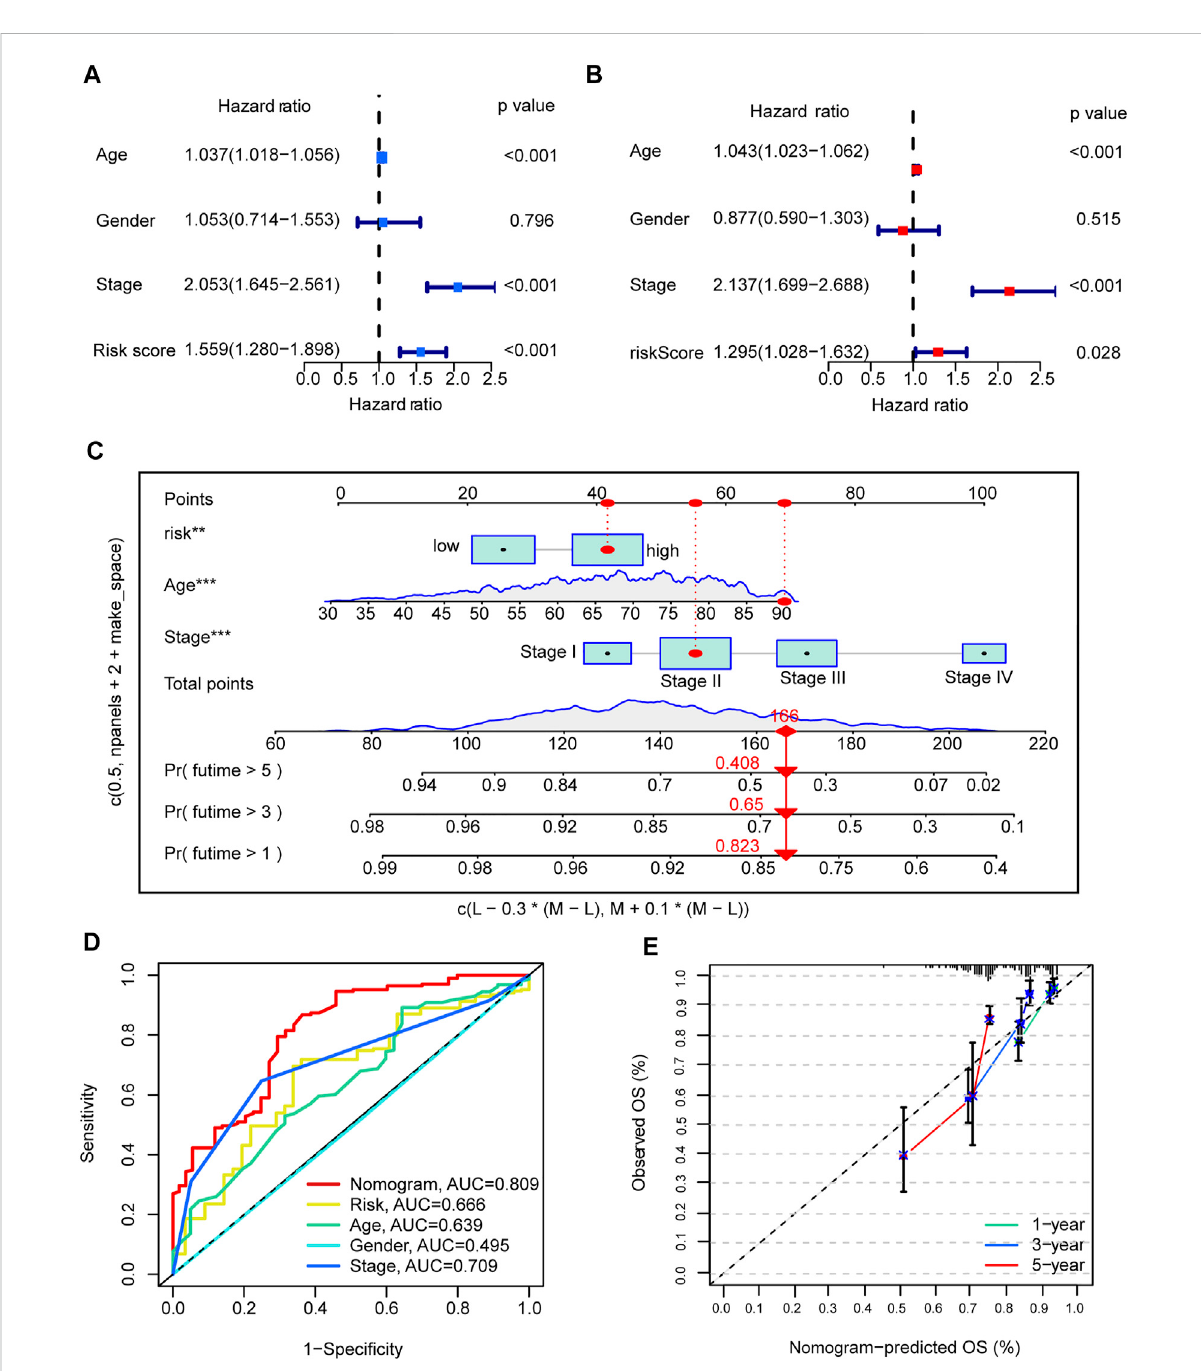
FIGURE 4 Development and evaluation of nomograms. (A,B) univariate and multivariate Cox analyses of CRG risk score and clinical information with overall survival. (C) nomogram. (D) The AUC value of Nomogram in the ROC curve is 0.809. (E) Calibration plots illustrate nomogram with excellent predictive power at 1st, 3rd and 5th